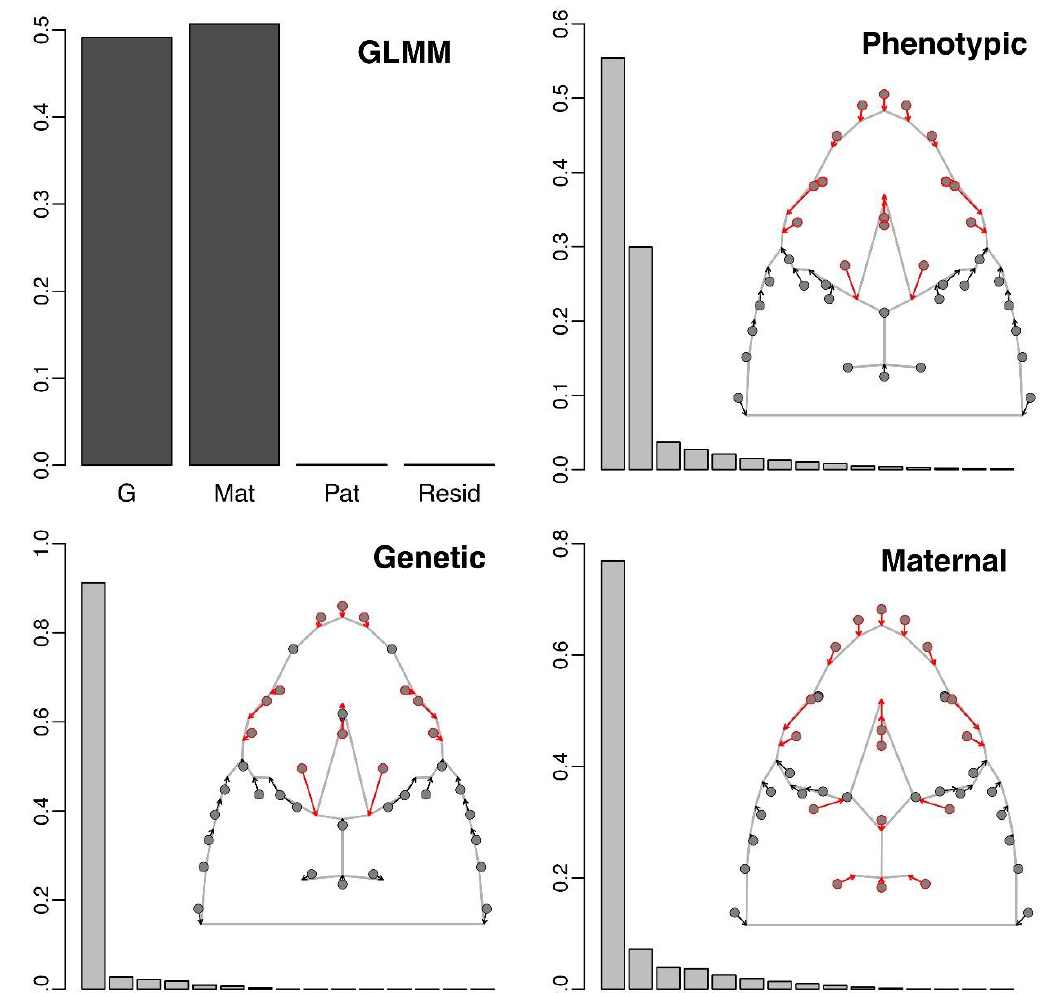
Figure 2. Relative importance of the additive genetic ( G ), maternal ( Mat ), paternal ( Pat ) and residual effects in explaining the total phenotypic variance in a GLMM (top left), as well as structure of the corresponding effect matrices visualized through the distribution of their relative eigenvalues. In all plots, the y -axis represents the proportion of variance explained (on a 0 – 1 scale). The arrows in red depict the highest variation of the phenotype from the three variance matrices.